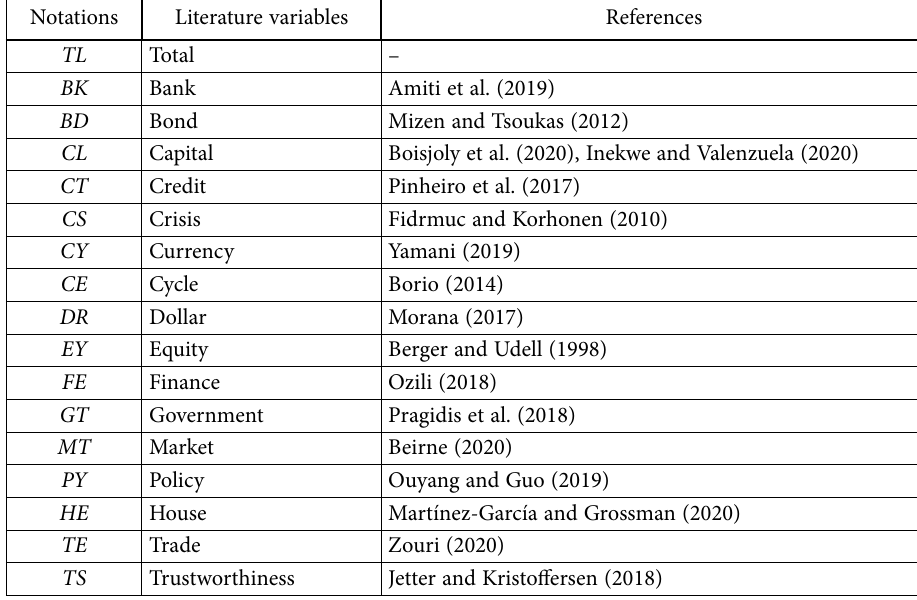
Table 2. Notations and references of literature variables (source: authors’ own